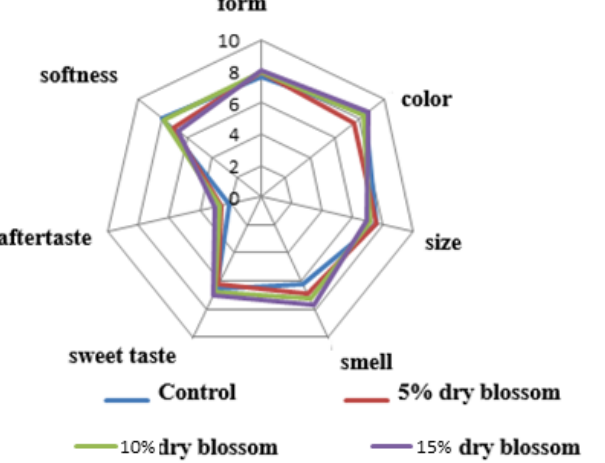
Figure 4. Sensory profile of sponge cakes made with elderberry blossom flour (5, 10, and 15%). The textural characteristics of the samples are presented in Table 3. Linear correlations (Table 4) were found between the hardness and elasticity of the sponge cake, as well as between the hardness and concentration of Sambucus nigra L. flour. Table 3. Textural properties of Control and Options 1, 2, and 3 sponge cakes.